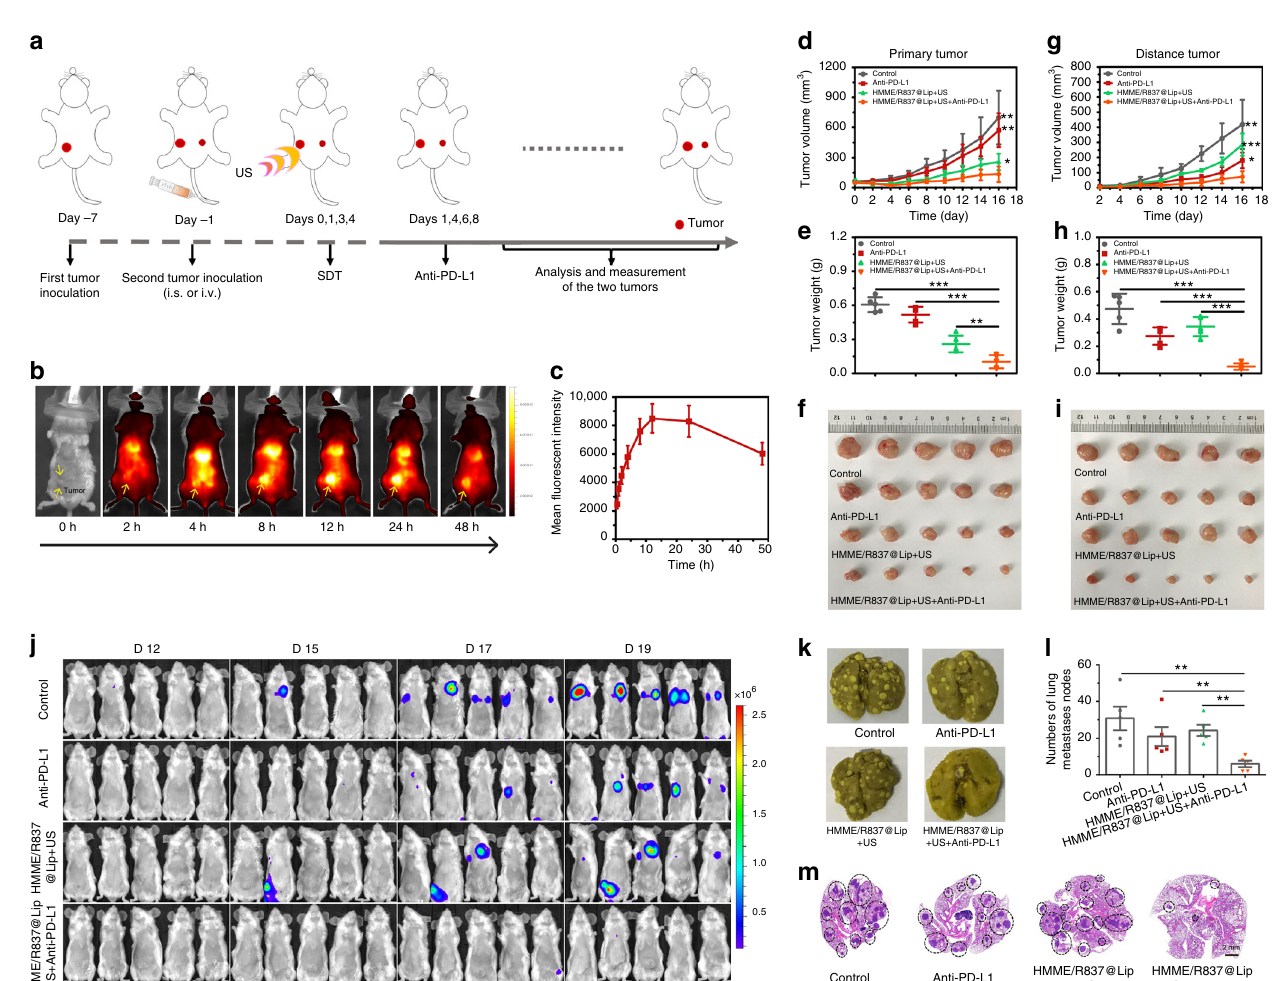
Fig. 6 Antitumour effect of HMME/R837@Lip-augmented SDT plus anti-PD-L1 immunotherapy in orthotopic tumour models. a Schematic illustration of HMME/R837@Lip-augmented SDT and anti-PD-L1 combination therapy to inhibit tumour growth at the distant sites on orthotopic tumour models; b in vivo fl uorescence images to study the biodistribution of HMME/R837@Lip post i.v. injection in 4T1 orthotopic tumour-bearing mice at the indicated time points. Yellow arrows indicate tumours; c the accumulation curve of HMME/R837@Lip in the tumour tissue by measuring the fl uorescence of tumours at different time points post i.v. injection, error bars are based on SD ( n = 3); d – i primary ( d ) and distant ( g ) tumour-growth curves of different groups of orthotopic tumour-bearing mice after various treatments as indicated in the fi gure. Error bars are based on SD ( n = 5); average weights of primary ( e ) and distant ( h ) tumours at the end of treatments; photographs of excised primary ( f ) and distant ( i ) tumours at the end of treatments; j in vivo bioluminescence images tracking the spreading and growth of i.v. injected fLuc-4T1 tumour cells in the mice after different treatments; k representative photographs to show the gross appearance of tumour nodules in the lungs; l the numbers of lung nodules were counted under anatomy microscope. Values are means± standard error (SE) ( n = 5); m representative haematoxylin and eosin staining analysis of the lung metastasis. Scale bar = 2 mm. Statistical signi fi cances were calculated via Student ’ s t test, * p < 0.05, ** p < 0.01 and *** p <